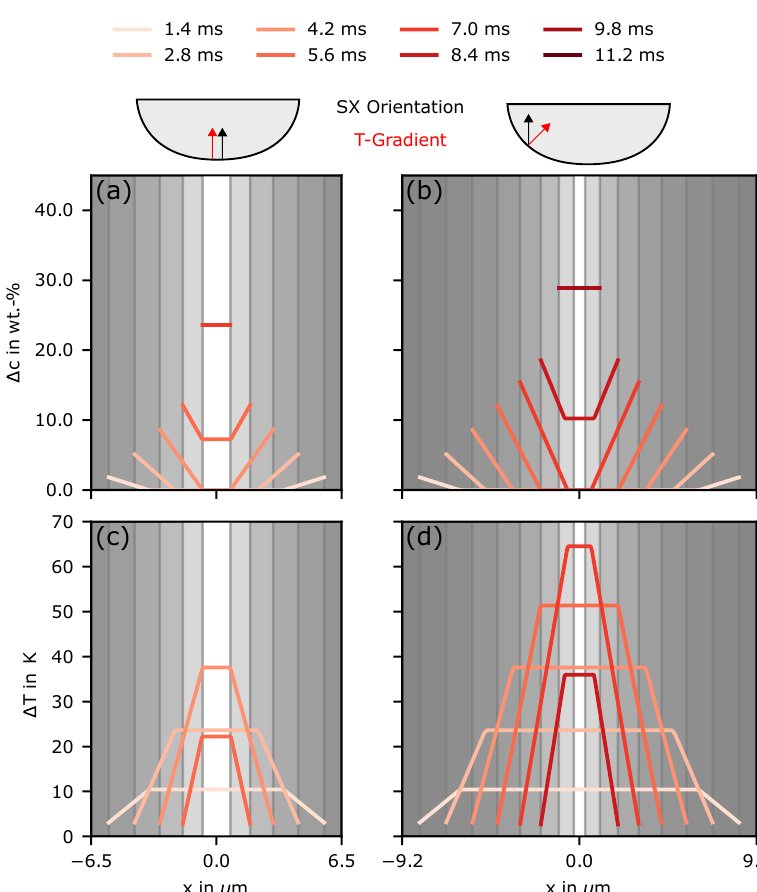
Figure 7. ( a ) Concentration variation ∆ c = c l − c 0 in the interdentritic space over several times at the bottom of the first melt line ( a ) where the temperature gradient is parallel to the main growth direction of the underlying SX and at an angle of 45° towards the SX orientation ( b ). For ( a , b ) the same temperature evolution as in Figure 6 was used for better comparison. For ( b ), the effective dendrite arm spacing λ ff was calculated and used instead of the original λ of 13µm. ( c , d ) The corresponding undercooling ∆ T evolution based on the local concentration/liquidus temperature and the local temperature evolution at the point marked in Figure